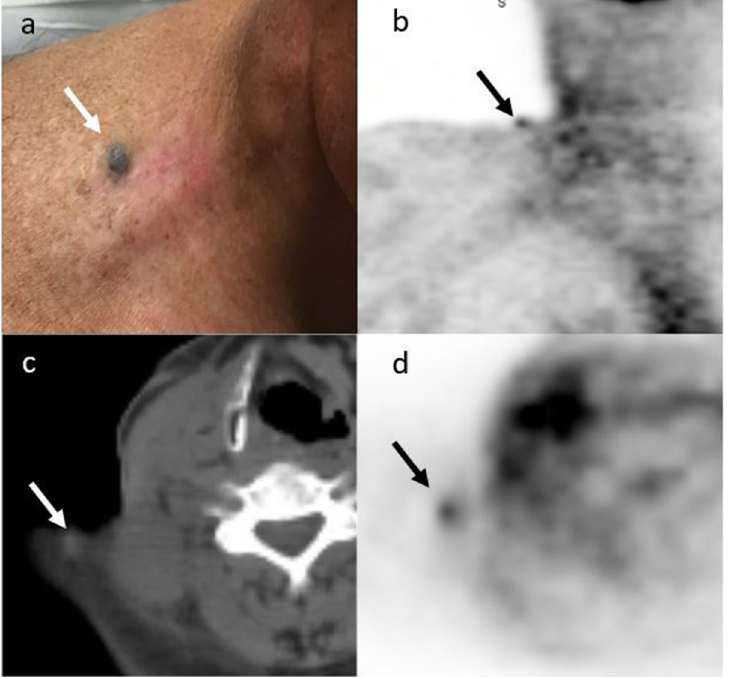
Figure 1. ( a ) Printex ink injected into subcutaneous tissue of the postoperative bed (white arrow). ( b ) Coronal PET image through ink injection demonstrating FDG avid lesion (black arrow). ( c ) On the axial CT component of the PET-CT, a focally dense area is evident corresponding to the region of the injected ink (white arrow). ( d ) Registered PET image to CT from ( c ). The area noted on the CT is FDG avid (black